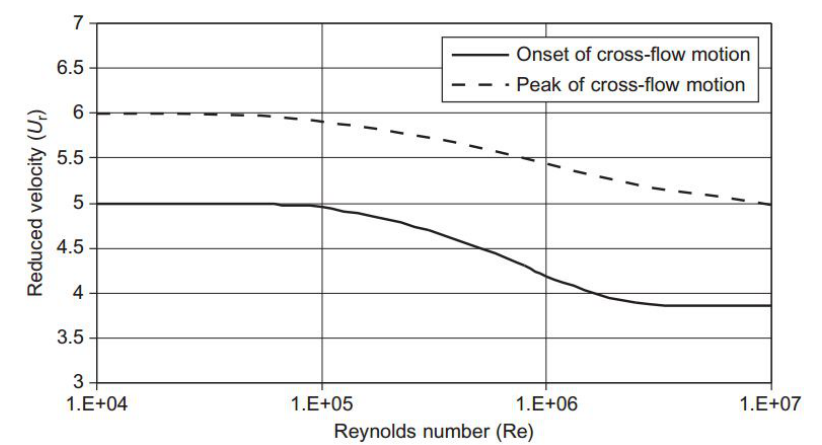
Figure 3. Reduced velocity for Cross-flow oscillations based on Reynolds number Re [17]. (Figure